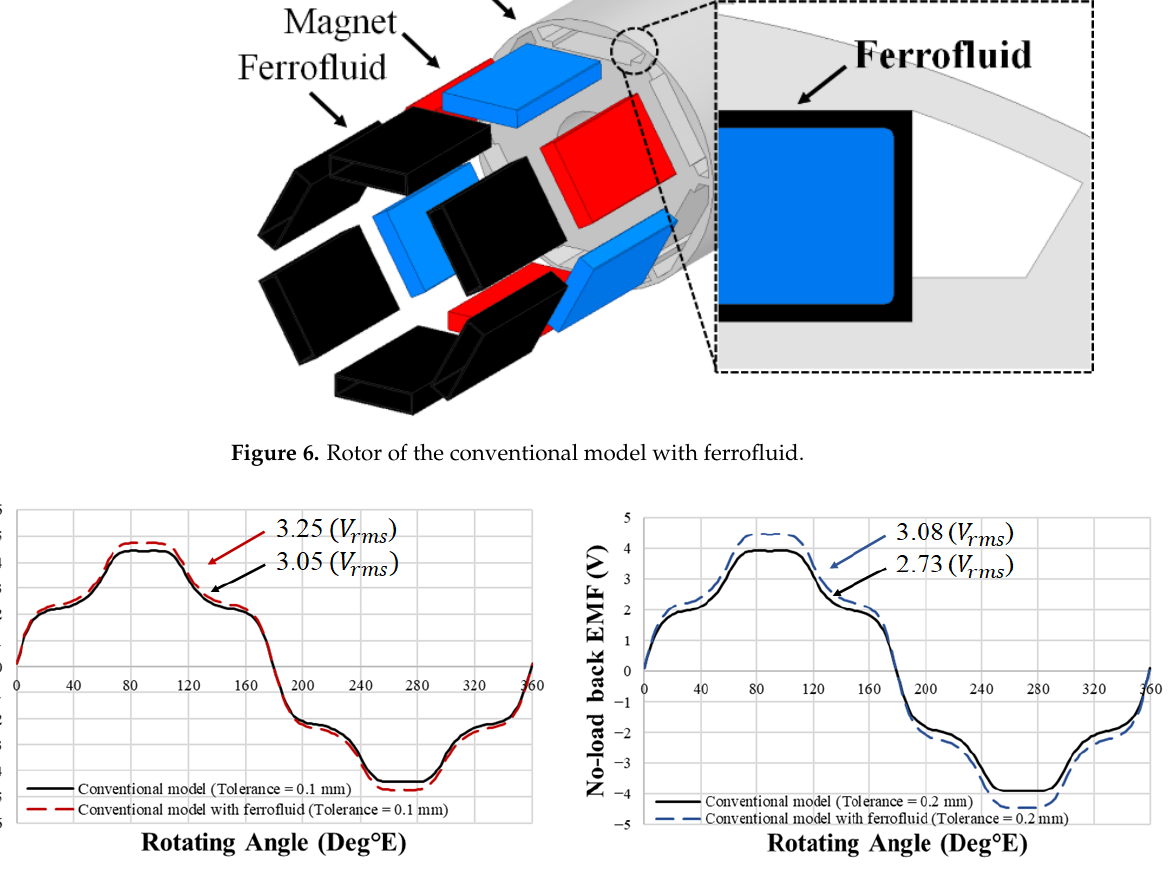
Figure 6. Rotor of the conventional model with ferrofluid.